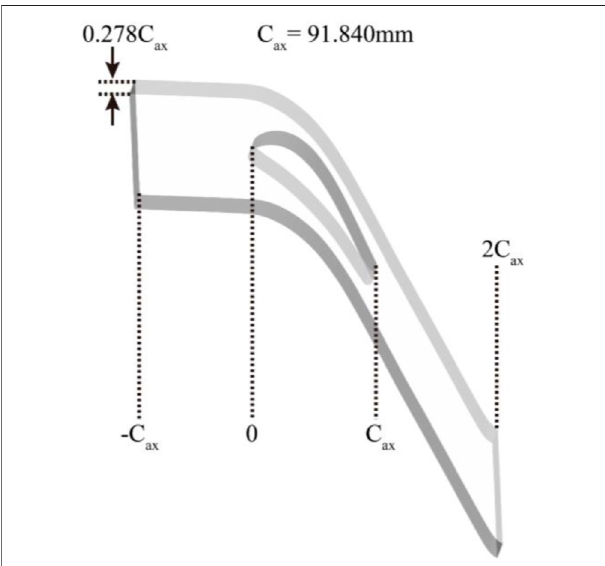
FIGURE 4 | Computational mesh and details at the leading and trailing edges.